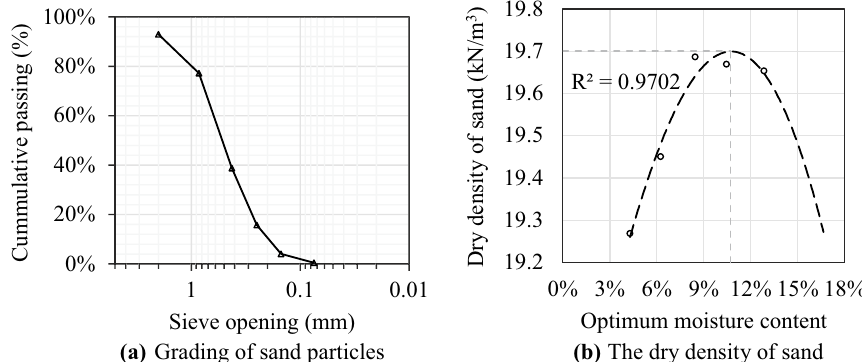
(a) Grading of sand particles (b) The dry density of Fig. 5 Dry density of sand inside the sandbox ( a ) gradation, and ( b ) maximum dry